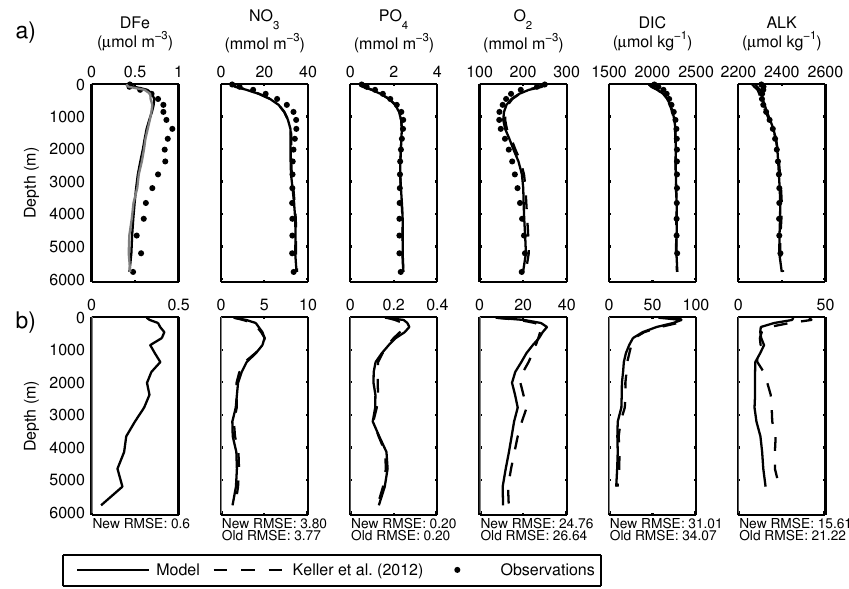
Figure 6. Vertical profiles comparing dissolved iron (DFe), nitrate (NO 3 ), phosphate (PO 4 ), oxygen (O 2 ), dissolved inorganic carbon (DIC) and alkalinity (ALK) with observations from Tagliabue et al. (2012), the World Ocean Atlas 2009 and GLODAP (a) and vertical profiles of the horizontally averaged absolute differences between model and the observations (b) . The gray line in the profile of dissolved iron is the horizontal average of simulated iron concentrations at the locations of the observations. The global root mean square errors (RMSE) relative to the observations are given below the respective panels in (b)